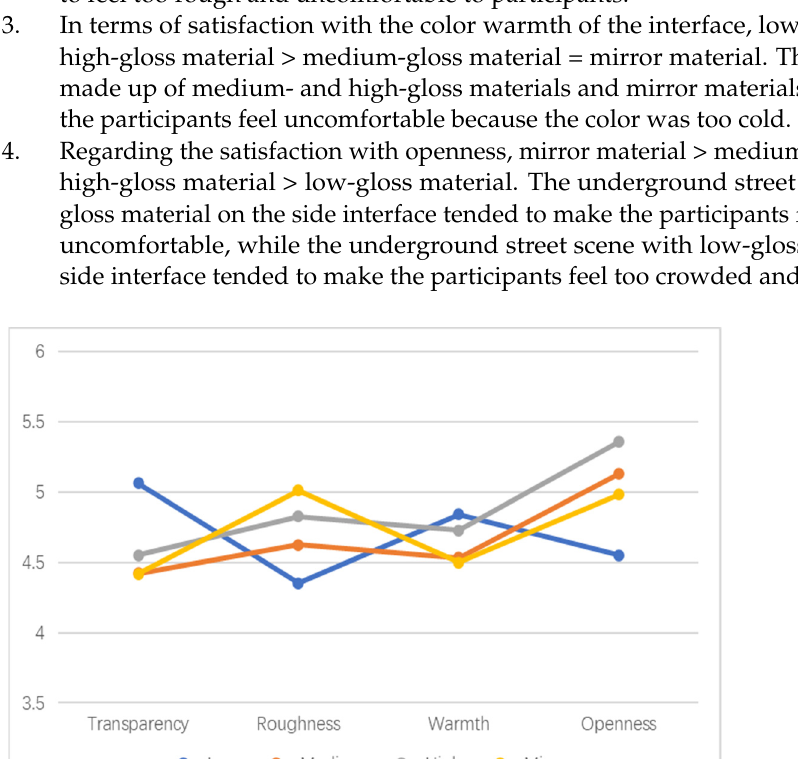
Figure 5. Mean value of concave/convex degree classification. The analysis of the mean value of satisfaction with the warmth and coldness of the color of the side interface material and texture classification (Figure 6) showed that the satisfaction with the color warmth and coldness of the side interface composed of materials with no directional texture > materials without texture = materials with